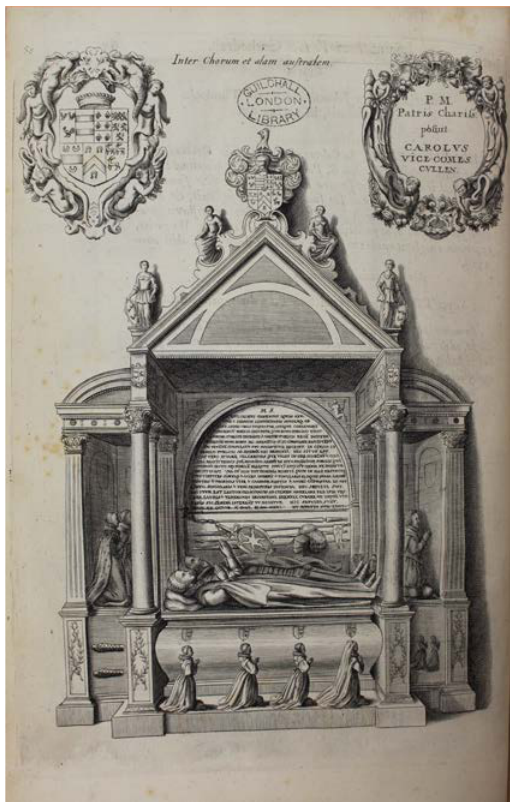
Figure 2 – Funerary monument of William Cokain (1626), partially destroyed in the great fire of London in 1661. Dugdale 1658, 65v., Guildhall Library, A 5.2 NO 6, London. Courtesy of Guilhdall Library,